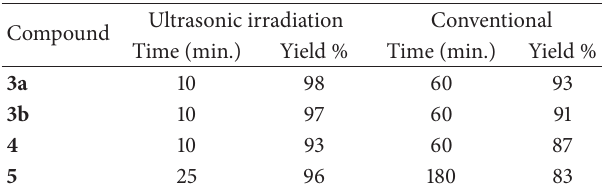
Table 1: Synthesis of pyrazole derivatives 3a-b , 4, and 5 under both ultrasonic irradiation and conventional